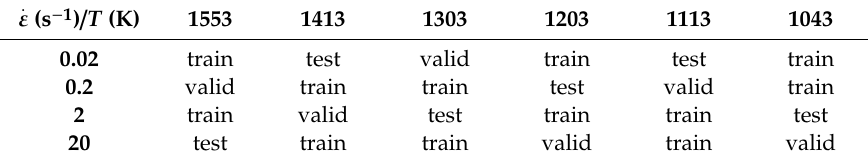
Table 2. Distribution of the temperature and strain rate combinations for the MLP learning purpose. 𝜺(cid:4662) (s − 1 )/ T (K)